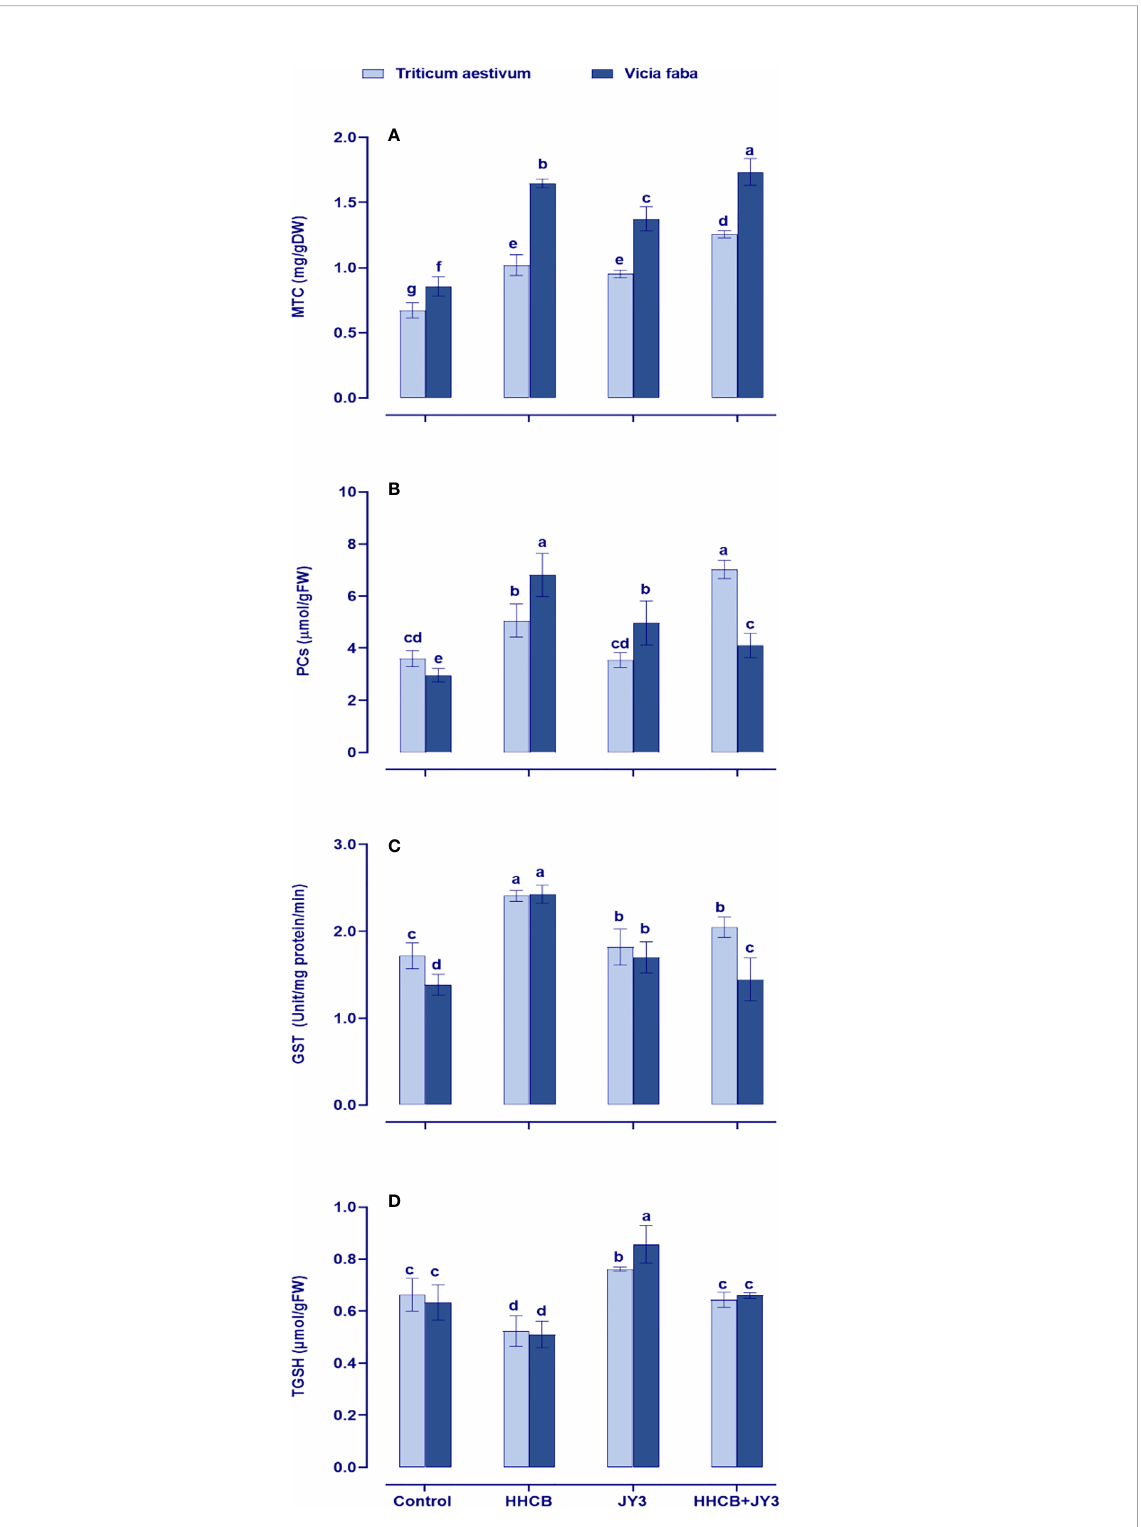
FIGURE 6 Effect of HHCB either alone or in combination with Rhodospirillum sp. JY3 on (A) metallothionein (MTC), (B) phytochelatins (PCs), (C) glutathione-s-transferase (GSH), (D) total glutathione (TGSH) of both wheat and faba beans. three biological replicates were used to detect each value. the bars on the columns represent error bars(SE). One-way ANOVA test was used to determine the signi fi cant difference between the groups. Similar letters in the bars indicate no signi fi cant dif fi dence between